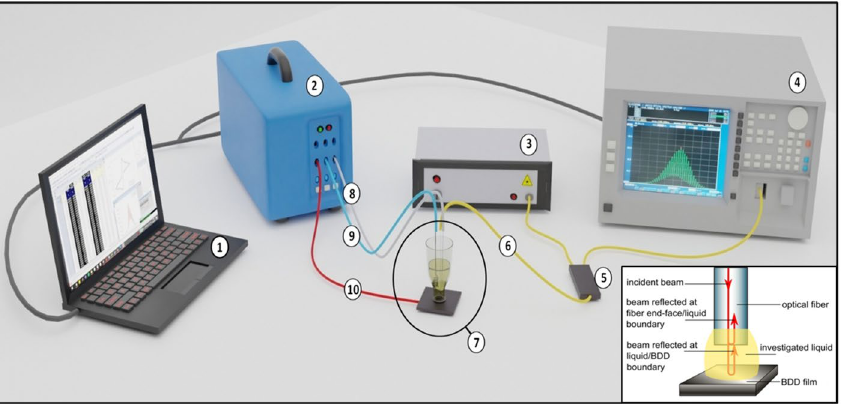
Figure 5. Measurement setup scheme (not to scale): 1—PC for storing and processing measurement data, 2— potentiostat–galvanostat, 3—light source, 4—optical spectrum analyser (OSA), 5—2 × 1 fiber coupler, 6—optical fiber, 7—measurement head, 8—connection to a reference electrode, 9—connection to a counter electrode, 10— connection to a working electrode. The inset figure shows a Fabry–Perot interferometer operation principle that was utilized in an optical part of the system. Reflected beams interfere with each other giving us a signal register by OSA.